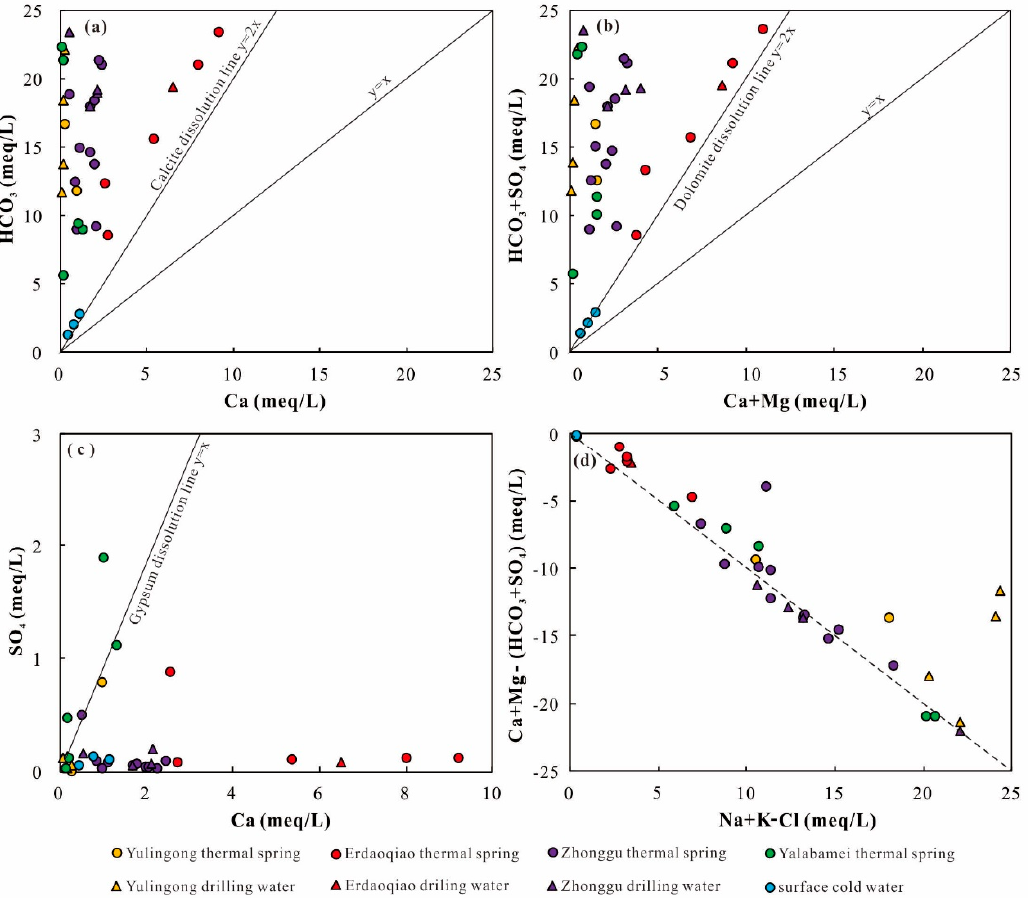
Figure 5. Diagrams used to identify hydrogeochemical processes based on the concentrations of major constituents in water. ( a ) Ca vs. HCO 3 , ( b ) Ca + Mg vs. HCO 3 + SO 4 ( c ) Ca vs. SO 4 , and ( d ) Na + K − Cl vs. Ca + Mg − (HCO 3 + SO 4 ).